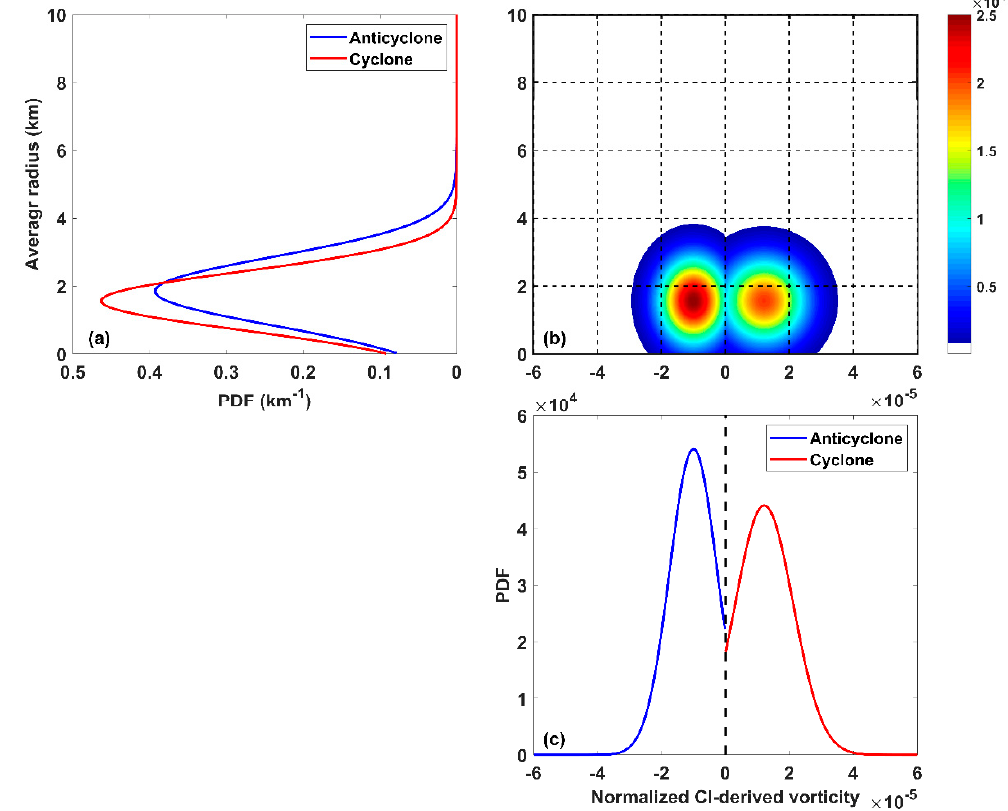
Figure 10. Probability density functions (PDFs) of the various characteristics of the identified submesoscale eddies from the CI-derived parameters. ( a , c ), 1-D PDFs for radius and vorticity; ( b ), joint PDF of radius